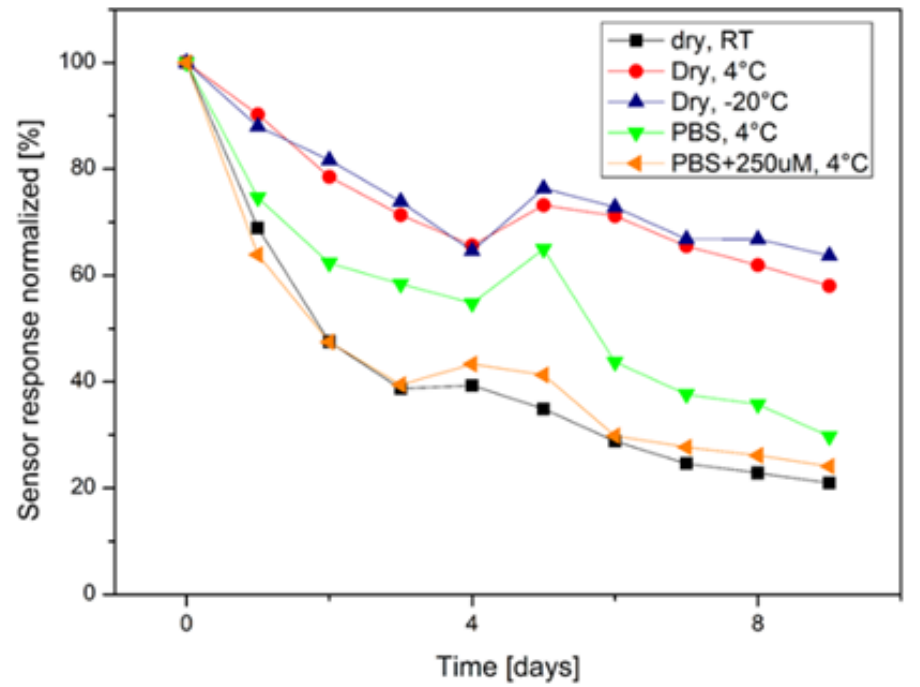
Figure A2. Preliminary comparison of different storing conditions for the biosensor. Response obtained daily in a 500 μM solution of L-lactate in PBS and normalized against response obtained on day 0.